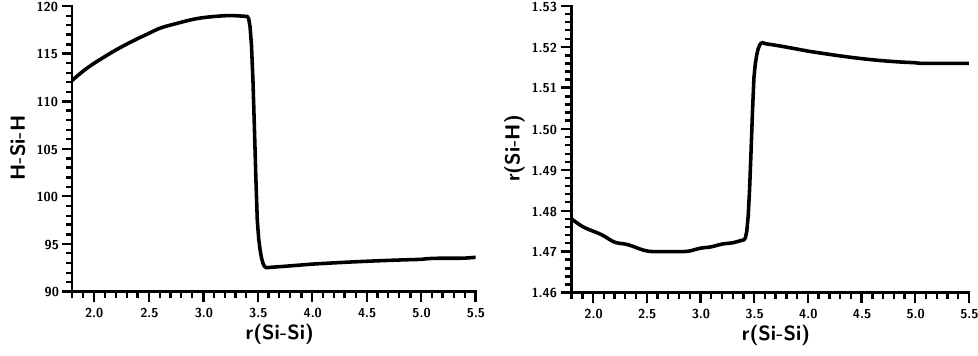
Figure 8. Planar silylene dimerization. HSiH bond angle (degrees) and SiH bond length (Å).